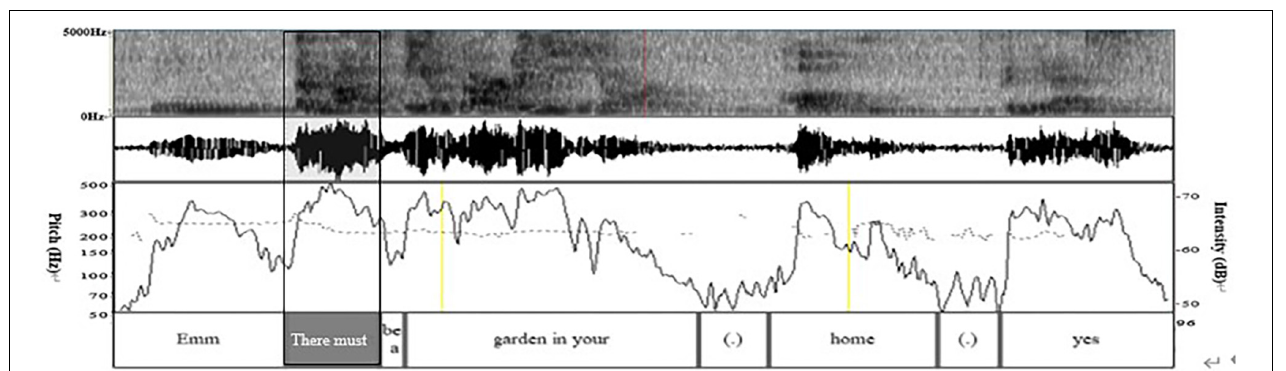
FIGURE 8 | Spectrogram, waveform, pitch trace (dotted line), and intensity trace (solid line) in lines 03–05 in excerpt